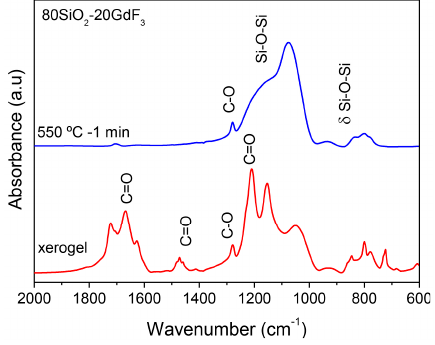
Figure 18. FTIR of 80SiO 2 -20GdF 3 xerogel and GC treated at 550 °C for 1 min.